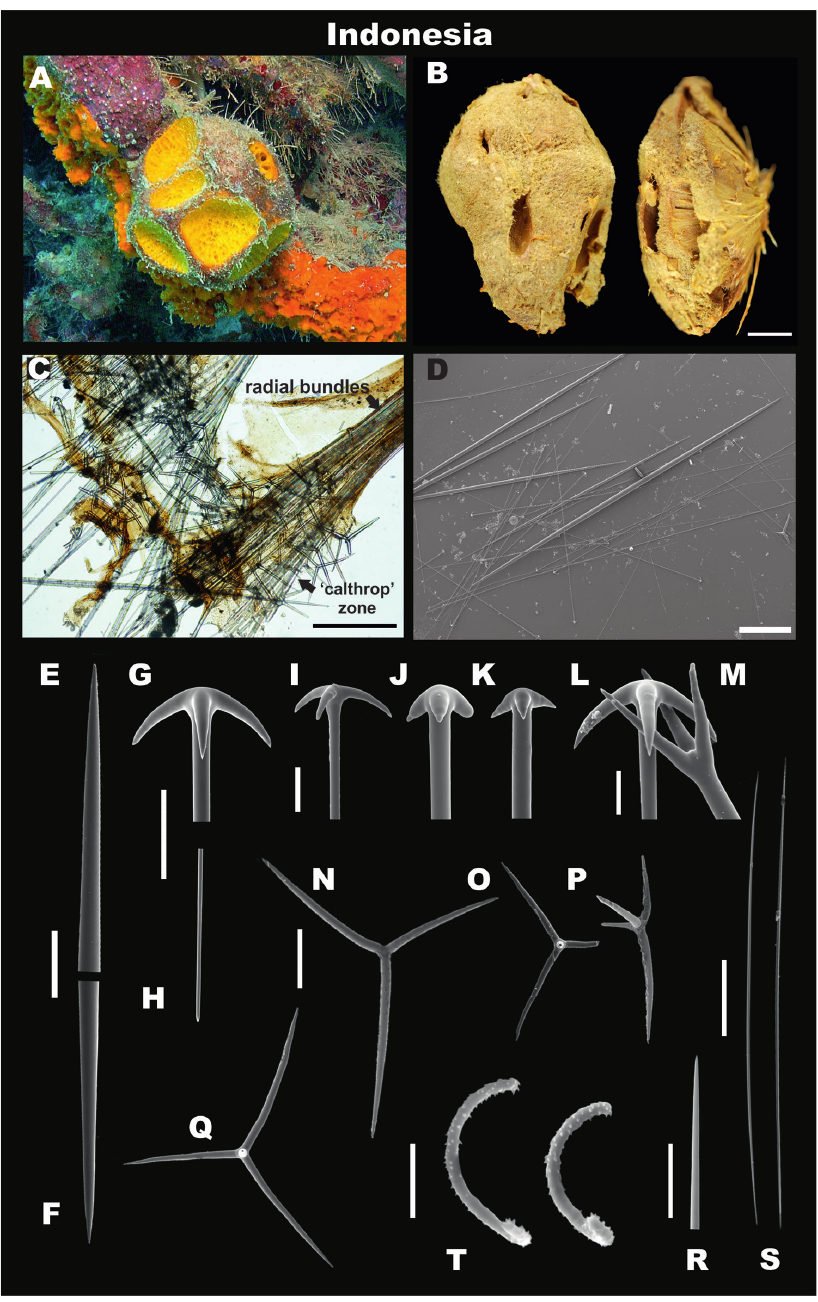
Figure 4. Paratetilla arcifera from Indonesia RMNH.POR.11266. A in situ photograph. B preserved specimen showing the porocalices (scale bar 1 cm) C skeleton D spicules E, F oxea, end detail G, H na- triaene, cladus. and rhabd end I-L anatriaene, different types M Protriaene N-Q different calthrops R thin microxea, detail S thin microxeas, full length T sigmaspires. Scale bars: 1 cm ( B ), 500 µm ( C,D ), 100 µm E,F ); 40 µm ( G,H ); 20 µm ( I–M ); 200 µm ( N–Q ); 5 µm ( R, T ); 50 µm ( S